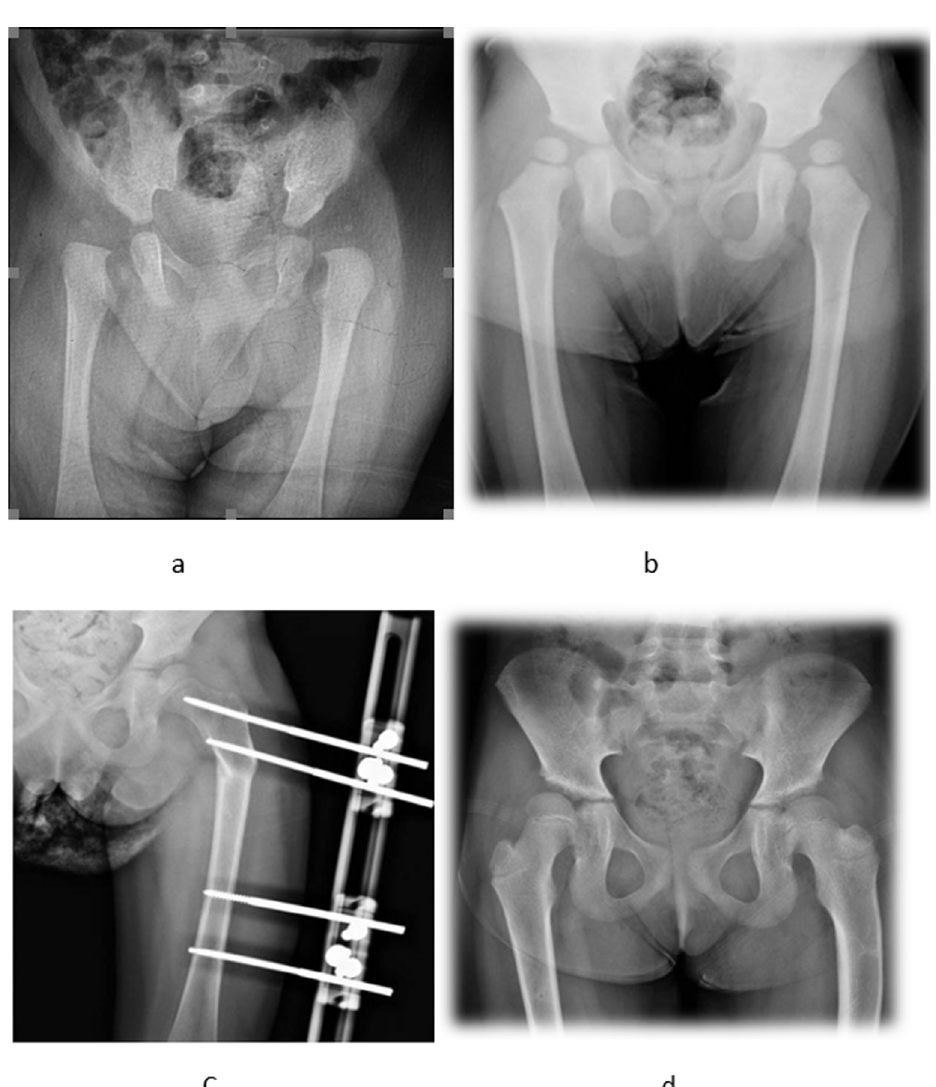
Figure 8. Cases example: Bilateral hip dislocation (a) was treated by Pavlic harness, ended up with left acetabular dysplasia, which persisted after a year of observation (b). FDVO was performed (c), and a good acetabular response after 2 years of follow-up